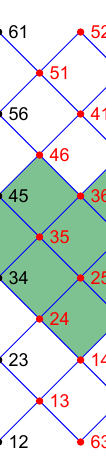
Figure 11 . Factorization of a square domain for the wave equation into smaller domains.